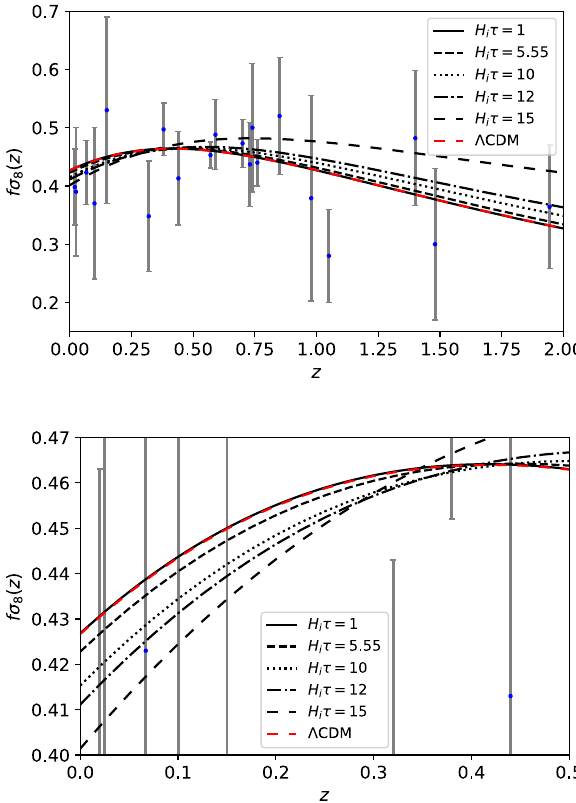
Fig. 11 The evolution of f σ 8 ( z ) at small and intermediate redshifts. The f σ 8 ( z ) data are taken from the compilation in Ref.